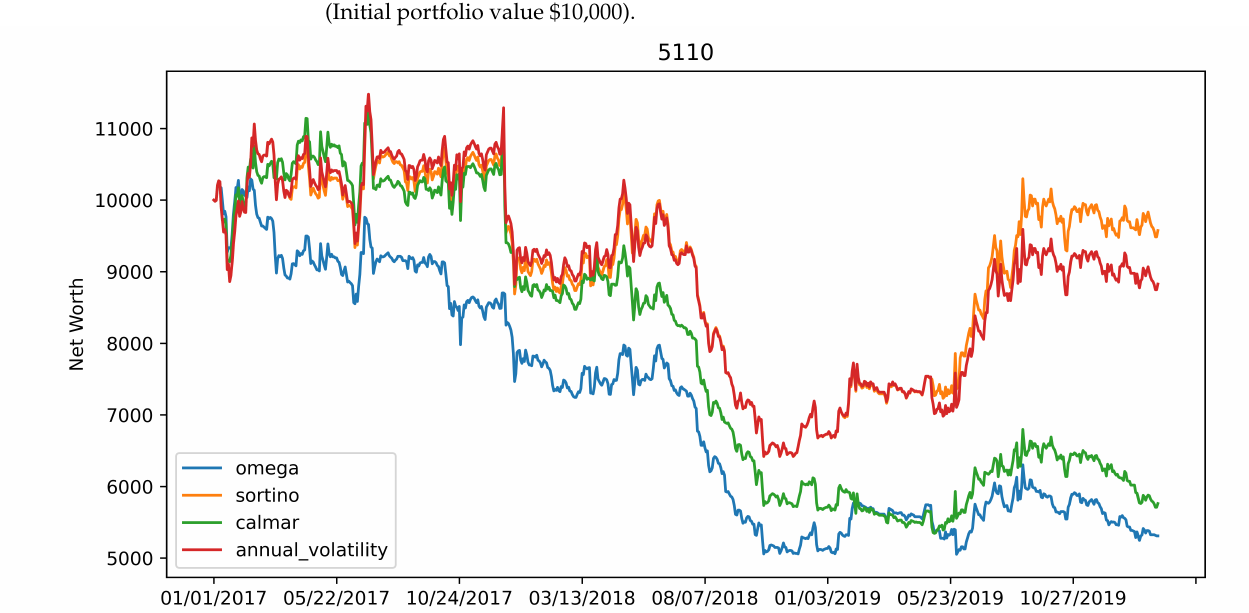
Figure 15. Outcome of 5110 stock net worth during model training with different reward functions (Initial portfolio value